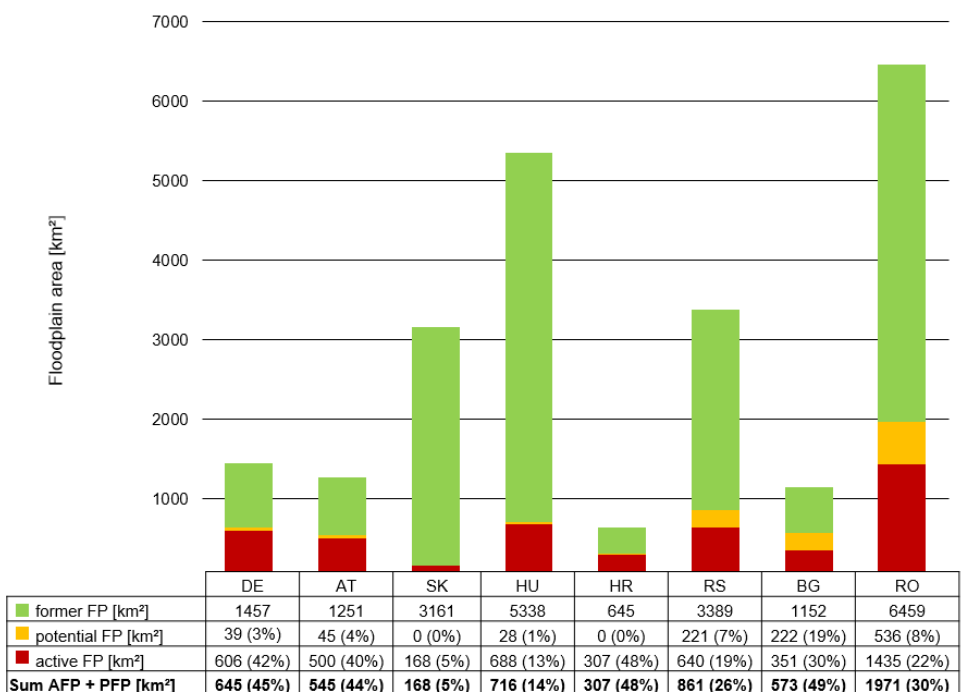
Figure 9. Area analysis of active, former, and potential floodplains along the Danube River. The percentages show how much of the former floodplains are still hydraulically active, or a potential floodplain, in each